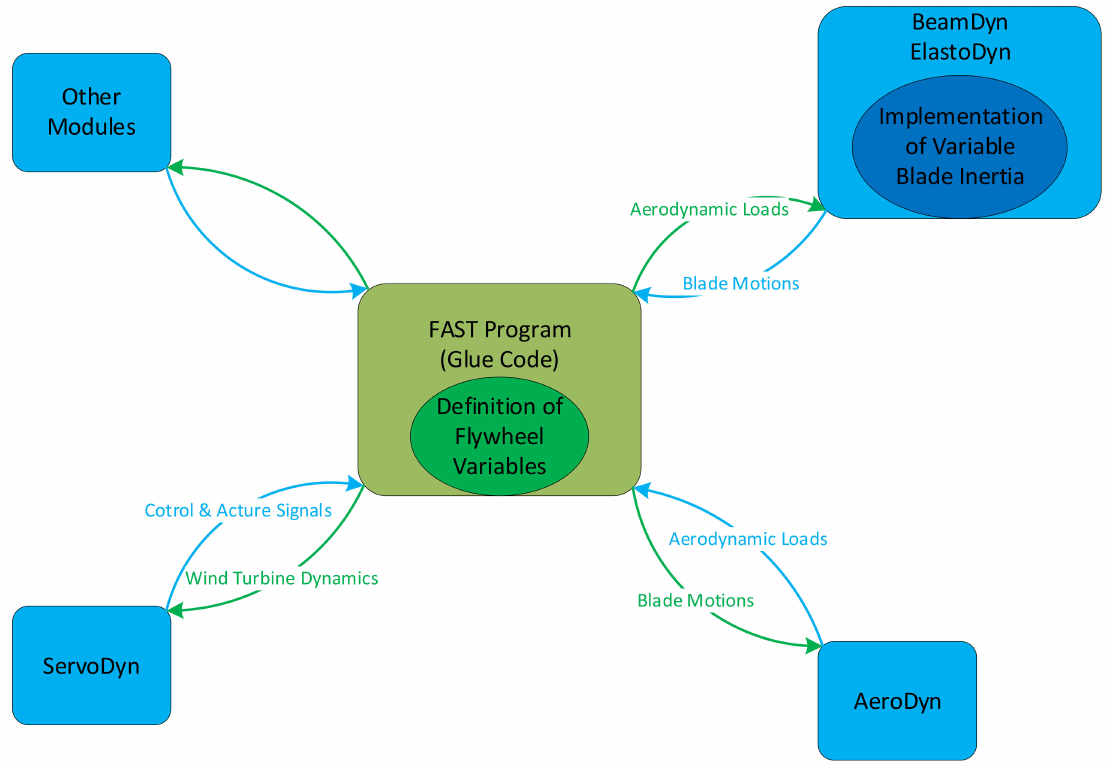
Figure 1. Coupled interaction between FAST and